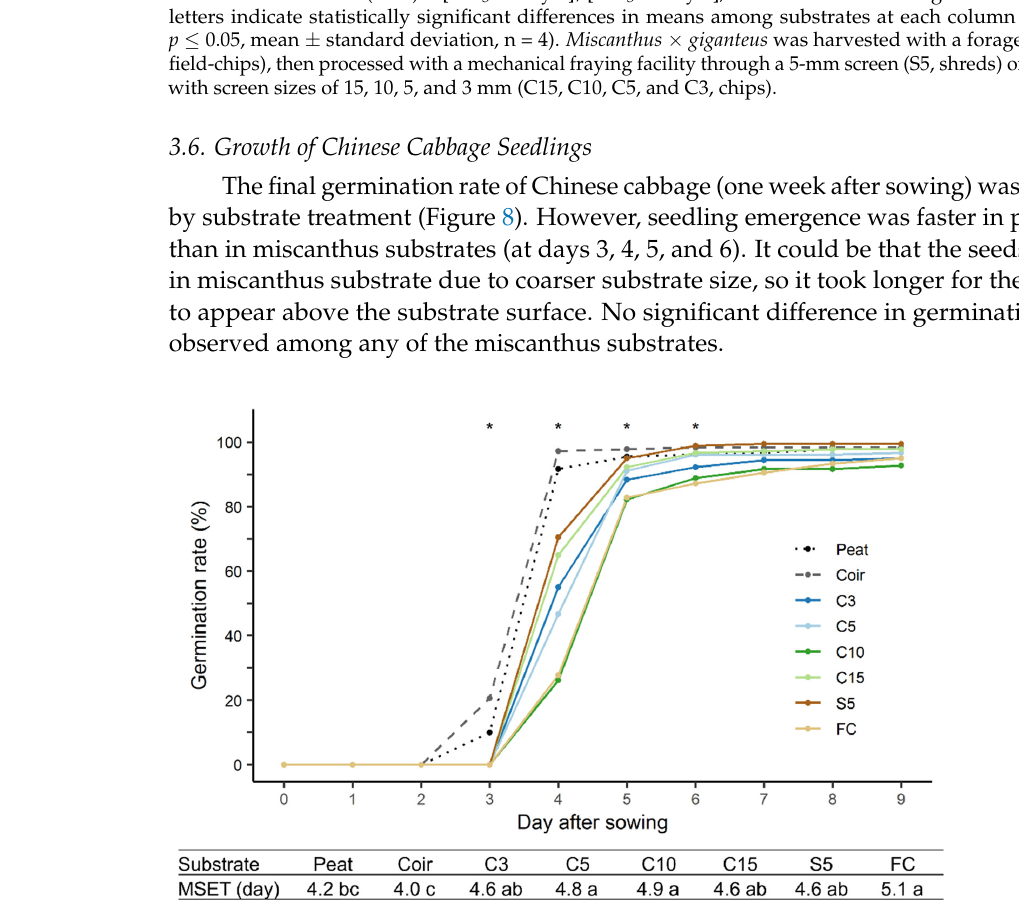
Figure 8. Germination rate of Chinese cabbage on peat, coir, and processed miscanthus substrates. Each point is the mean of germination rate of 4 trays. Each tray consists of 45 seeds. The asterisks at days 3, 4, 5, and 6 represent for significant differences in germination rate among tested growing media and different letters indicate significant differences for MSET (Tukey’s HSD, p ≤ 0.05). Mis- canthus × giganteus was harvested with a forage harvester (FC, field-chips), then processed with a